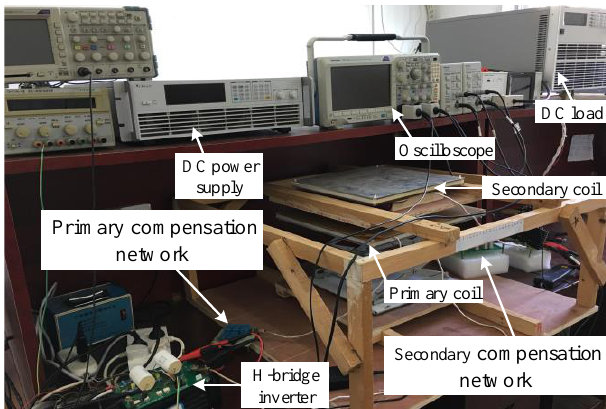
Figure 12. IPT system experiment